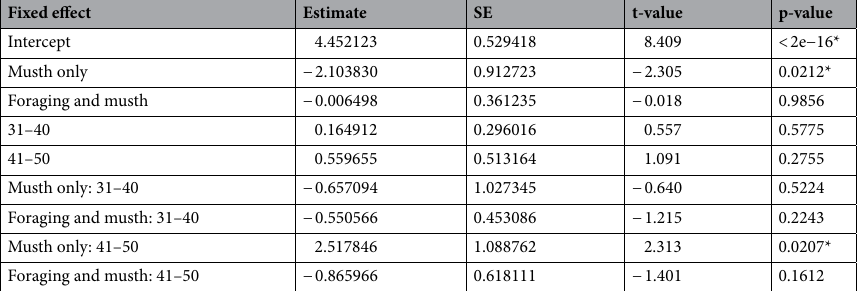
Table 2. Male BSI: model output from highest performing generalized linear model. Males following the musth-only (m) strategy showed significantly lower BSI values than males using the foraging-only (f) strategy or those doing both (f + m). Male strategy and age class interacted significantly for musth-only (m) at the highest age class, with higher BSI values than other